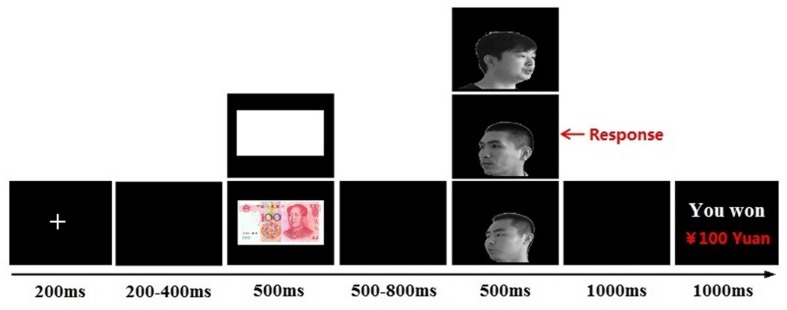
Single-trial settings. Each trial started with a fixation (200 ms), followed by a blank screen (200–400 ms, randomly). The cue stimuli (monetary reward/blank paper) was presented for 500 ms. After a blank screen (500–800 ms, randomly), a target face (self-face/friend-face/stranger-face) was presented for 500 ms. After a blank screen for 1000 ms, a feedback about cumulative earnings were presented for 1000 ms.